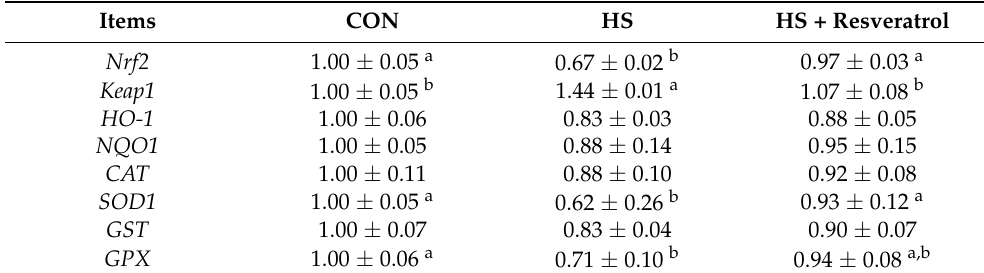
Table 7. Effects of resveratrol on the mRNA levels of Nrf2 signaling pathway-related genes in jejunum of broilers under